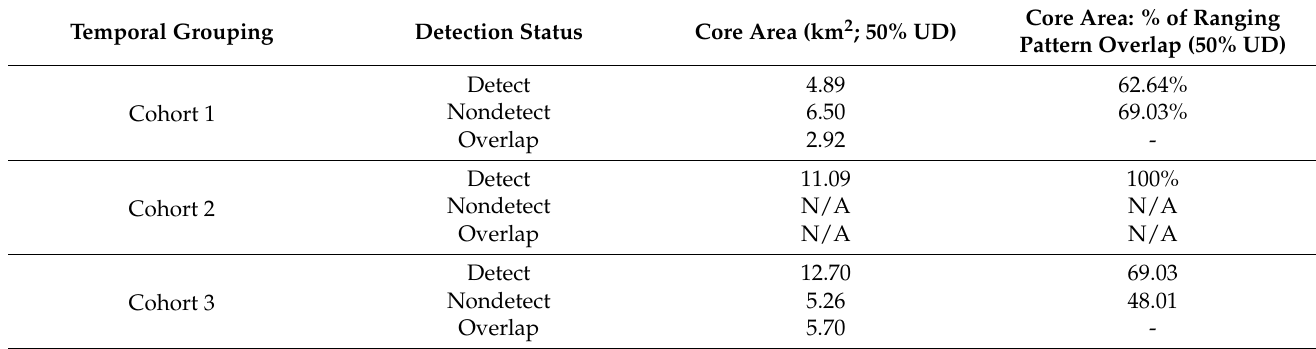
Table 4. The 50% utilization distributions (UDs) and percentage overlap for dolphins with de- tectable MEHP concentrations in the Sarasota Bay study area in Cohort 1 (detect: n = 3 individuals; n = 131 sightings; nondetect: n = 7 individuals; n = 171 sightings), Cohort 2 (detect: n = 12 individ- uals; n = 453 sightings), and Cohort 3 (detect: n = 14 individuals; n = 1502 sightings; nondetect: n = 15 individuals; n = 527 individuals)